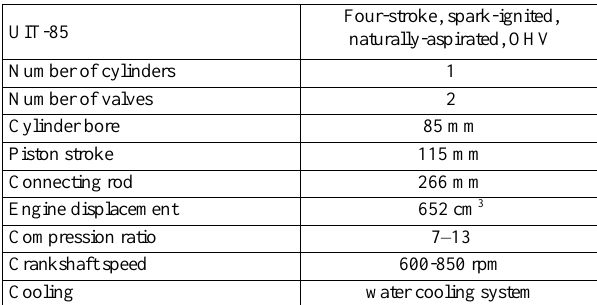
Table 3. Technical data of the engine UIT-85 [8]